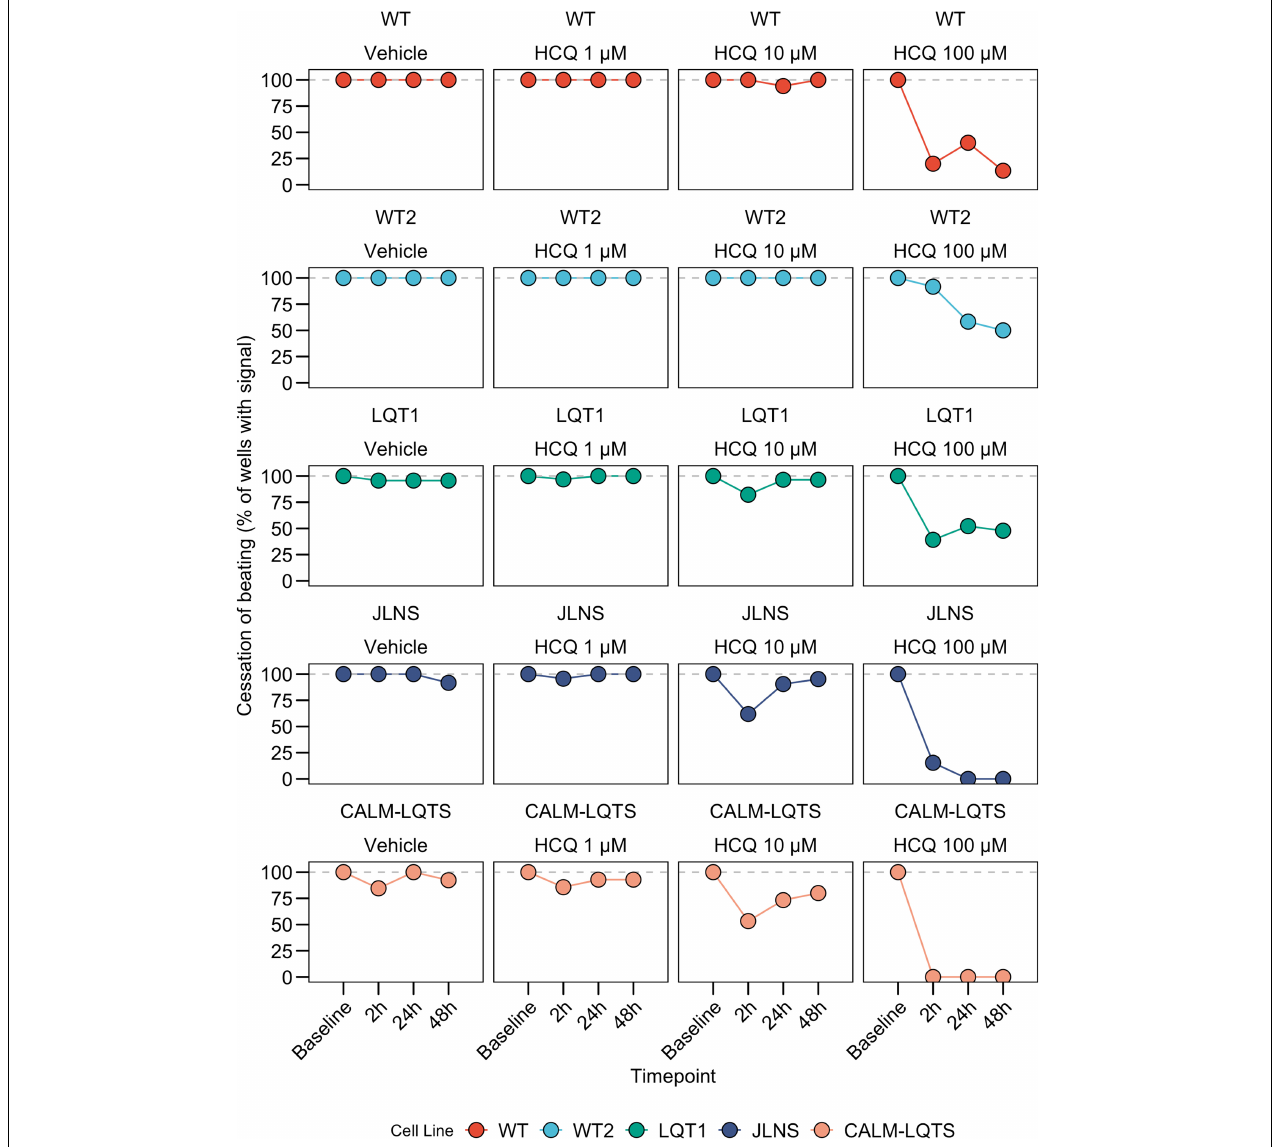
FIGURE 2 | Cessation of beating, intended as the proportion of wells with a quantifiable signal at each